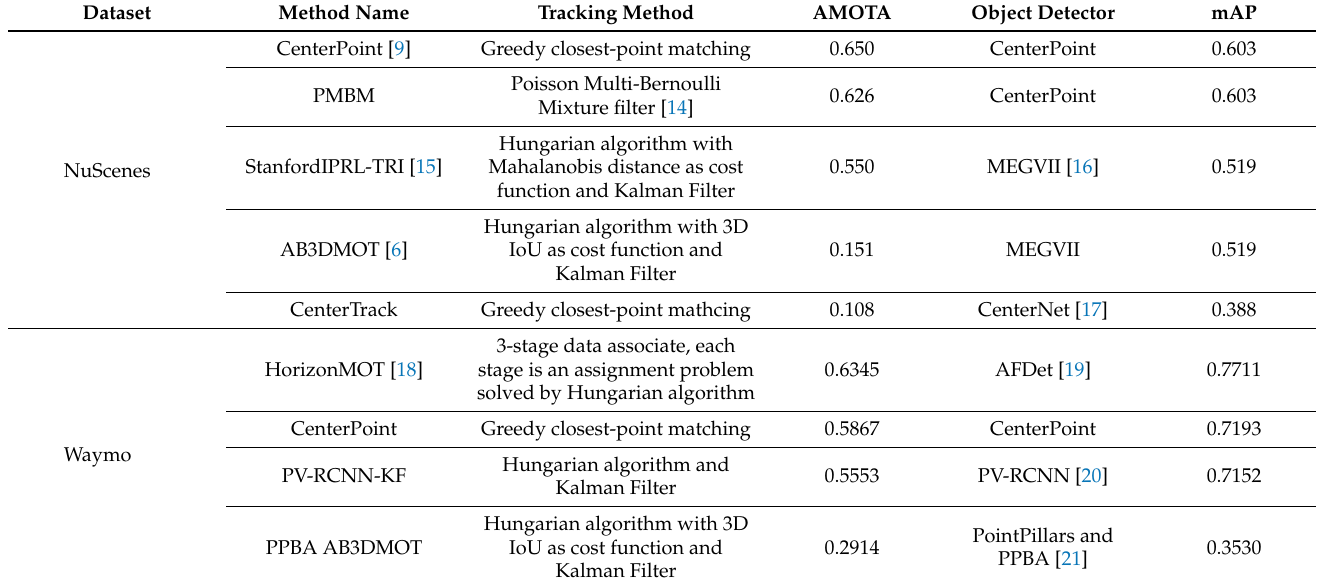
Table 1. Summary of tracking methods which details are published in the leader board of NuScenes and Waymo Open